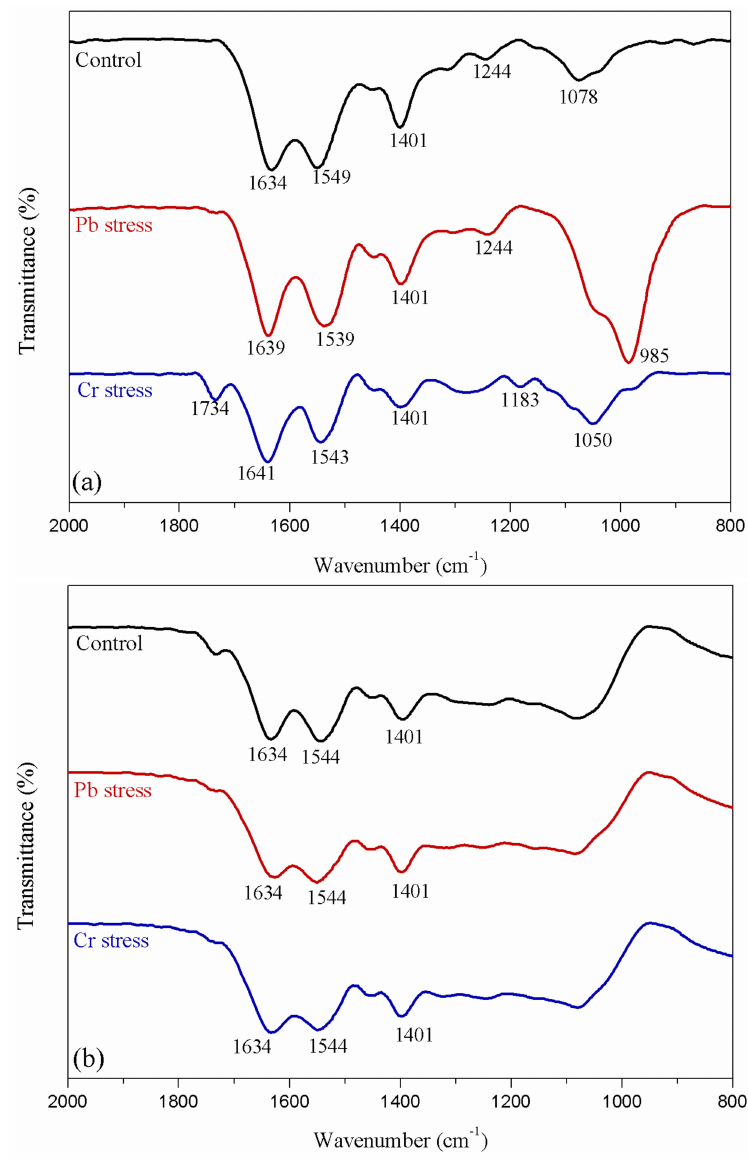
Figure 5. ATR-FTIR spectra of intact bacteria ( a ) and loosely bound EPS ( b ) under 1 mmol · L − 1 Pb and Cr